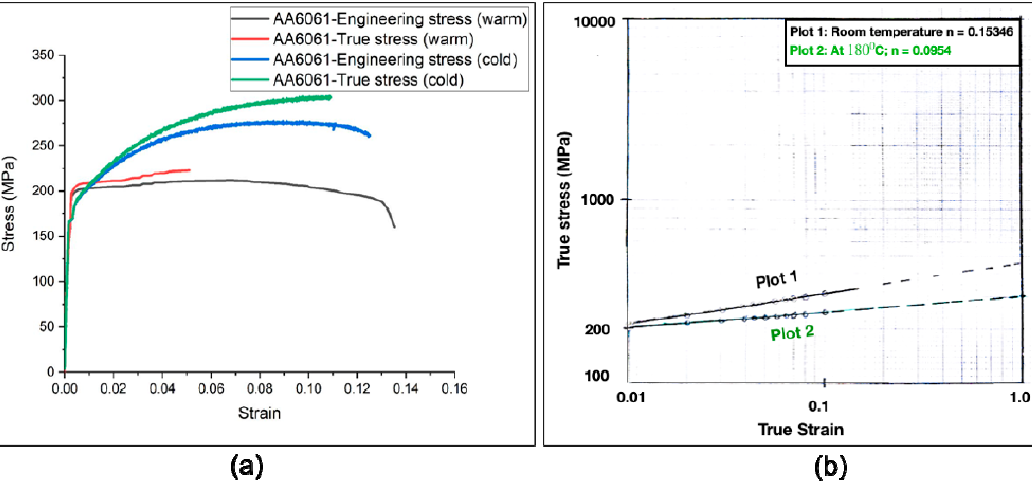
Figure 2. ( a ) Engineering and true-stress–strain curve for undeformed AA6061 sheet at room temperature and 180 °C, and ( b ) log–log plot for true-stress–true-strain up to strain = 1.0.